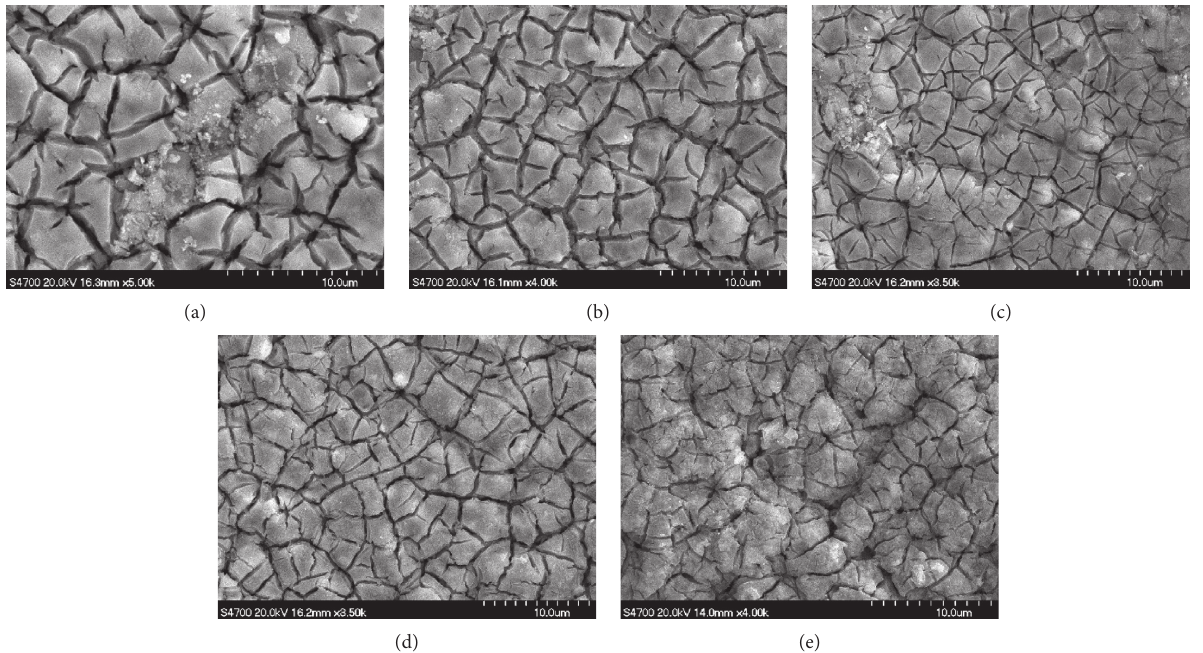
Figure 1: SEM images of Ti/SnO 2 -Sb-Ni/Gd electrodes with (a) Ni (0%), (b) Ni (1%), (c) Ni (2%), (d) Ni (3.5%), and (e) Ni (5%).